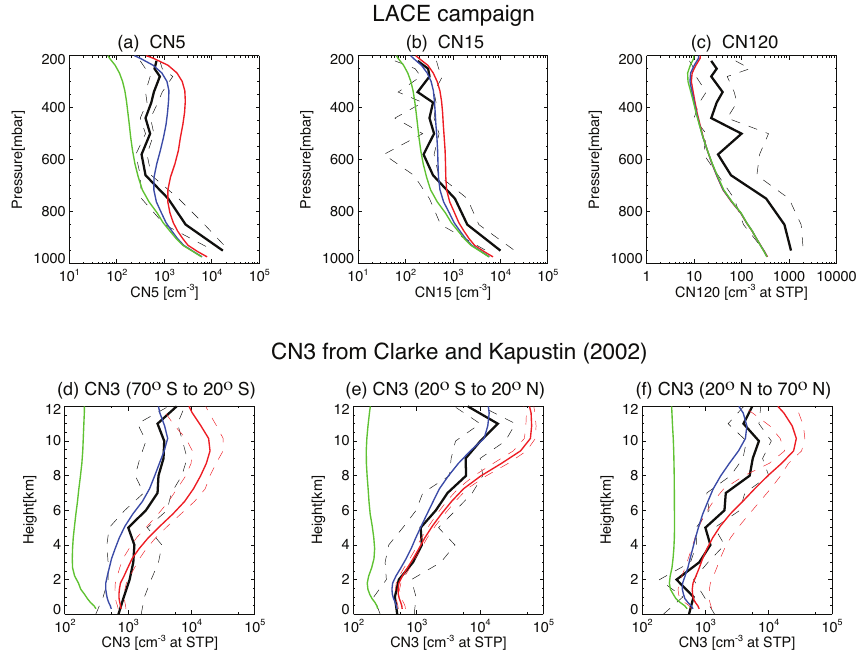
Figure 24. Vertical profiles of aerosol number concentrations from the observations (black lines) and ModelE2-TOMAS (red lines for the BASE run, blue lines for the LowNUC run, and green lines for the NoNUC run). The CN 5 , CN 15 , CN 120 concentrations (ambient conditions) from the LACE campaign (Petzold et al., 2002, in northeastern Germany) are shown in a to c , respectively. The observed CN 3 concentrations (STP conditions: 1atm, 273K) over the Pacific Ocean, which are averaged into the 3 latitude bands (70 to 20 ◦ S, 20 ◦ S to 20 ◦ N, and 20 to 70 ◦ N; Clarke and Kapustin, 2002), are shown in d to f . The dashed lines show the standard deviation for the observations and the min/max monthly mean for the model (only in d to f ).